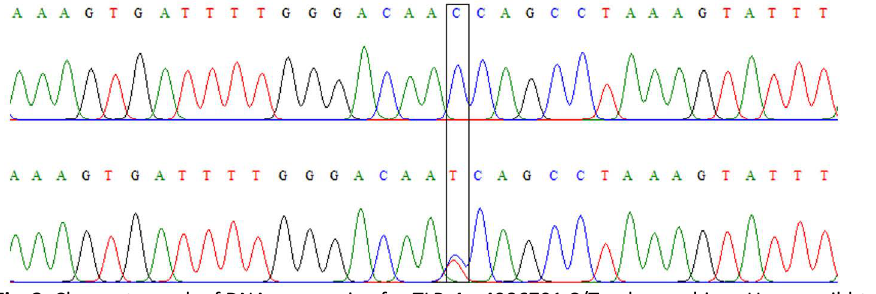
Fig. 3. Chromatograph of DNA sequencing for TLR-4 rs4986791 C/T polymorphism. Upper: wild-type homozygous genotype (CC), lower: heterozygous genotype